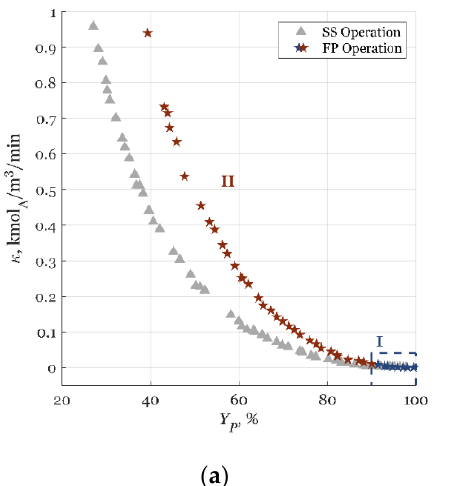
( a ) all obtained solutions and ( b ) chosen solutions for steady-state (SS) case (gray triangle), and forced